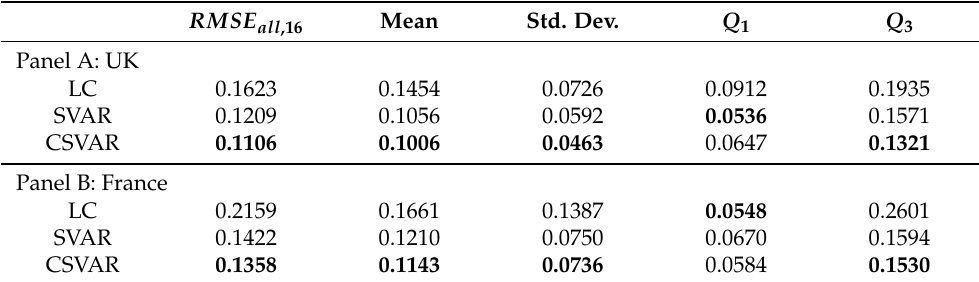
Table 1. Summary of RMSE over age groups. For each column, the smallest number is in bold. RMSE all ,16 Mean Std. Dev. Q